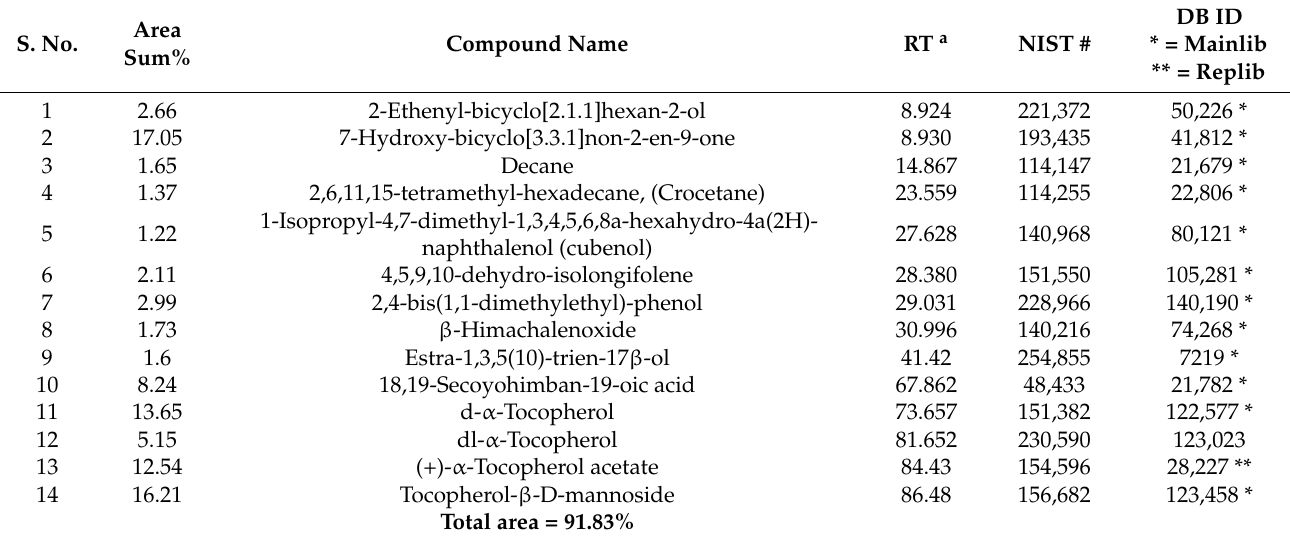
Table 1. Quantification assessment of major phytochemicals in EOAS.